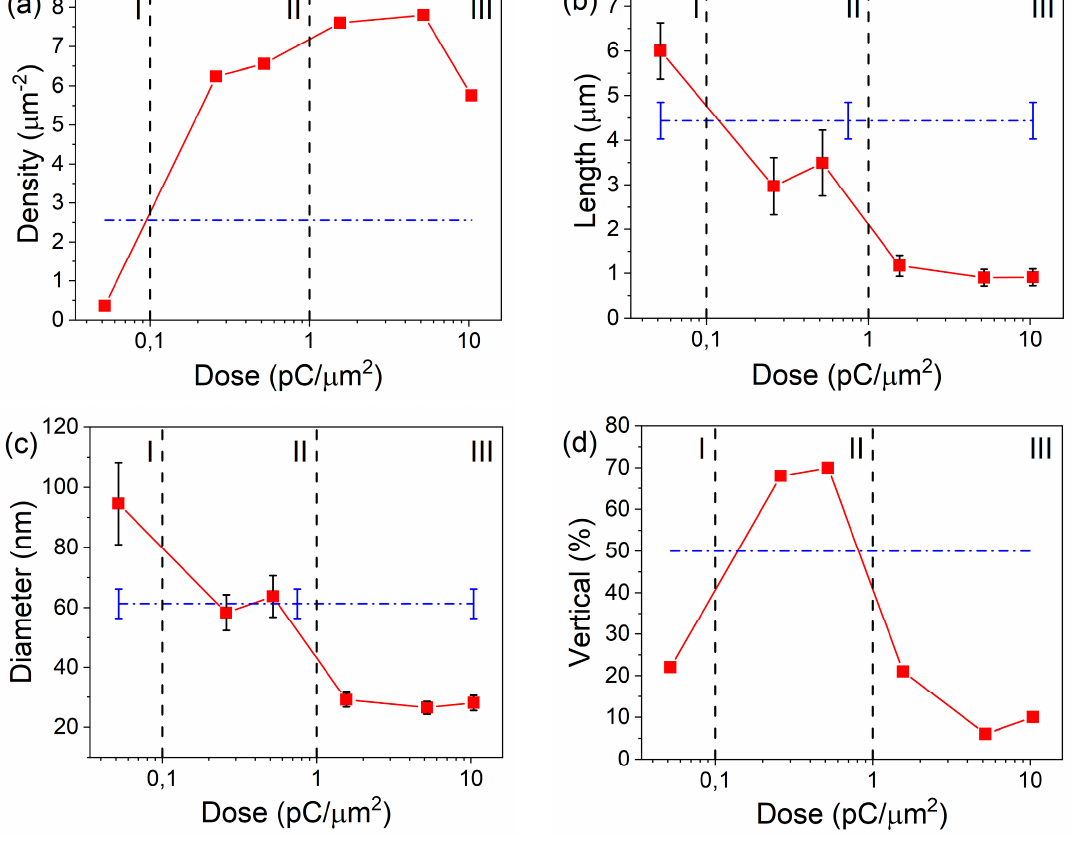
Figure 2. Dependences of the density ( a ), length ( b ), diameter ( c ), and vertical orientation of NWs ( d ) on Ga ion dose (dash lines correspond to values for unmodified areas).